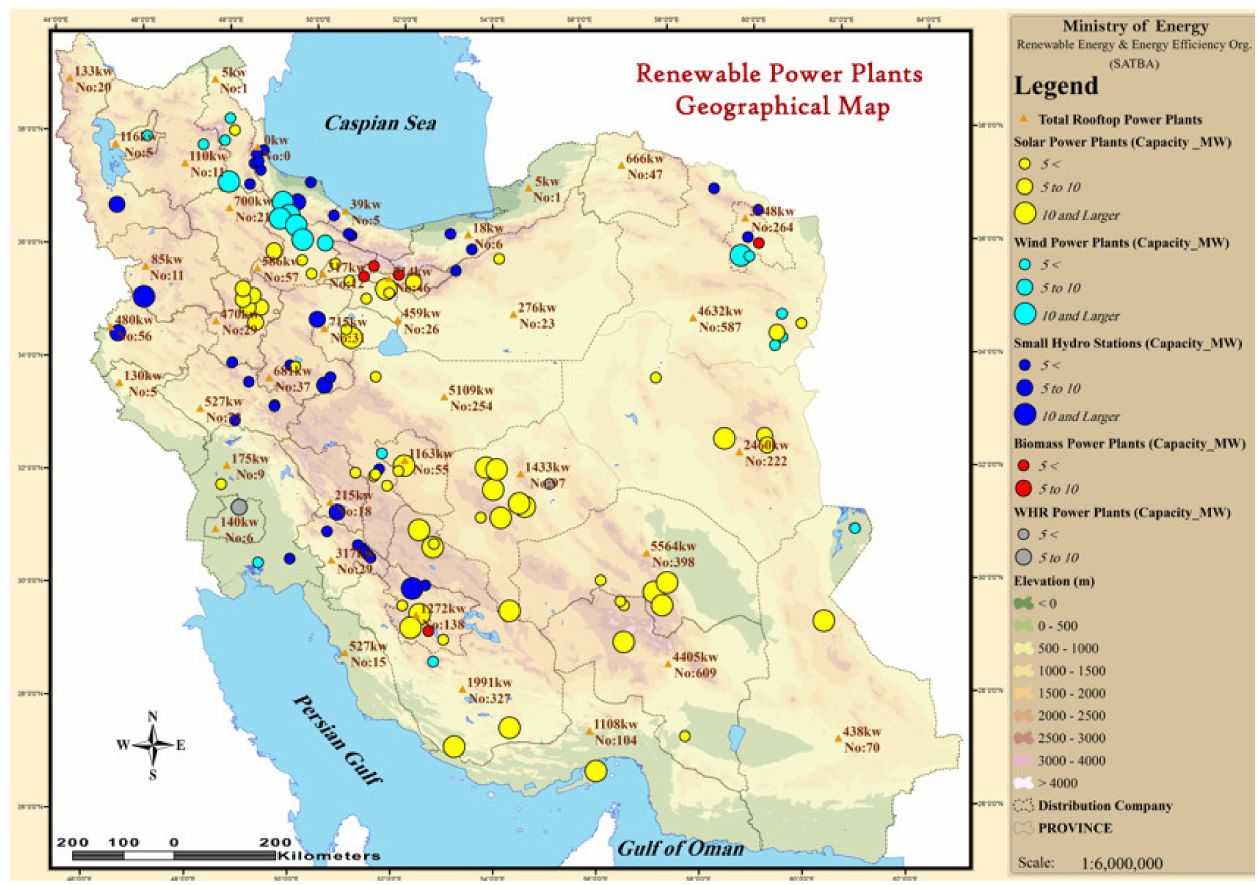
Figure 9. Geographical map of renewable power plants [123].